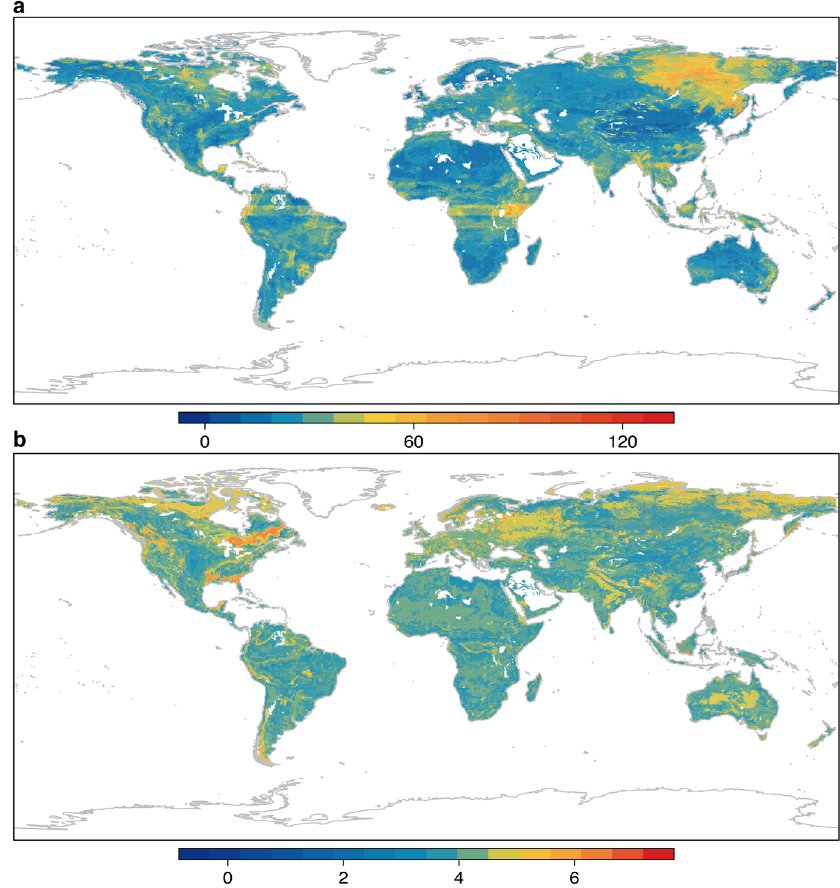
Fig. 4 Extrapolated global maps of soil seed banks. a diversity in terms of number of species per 0.01 m 2 ; b density as number of seeds per m 2 . In b , values are log10-transformed to facilitate viewing. The spatial resolution of grid cells is 5 arcmin-by-5